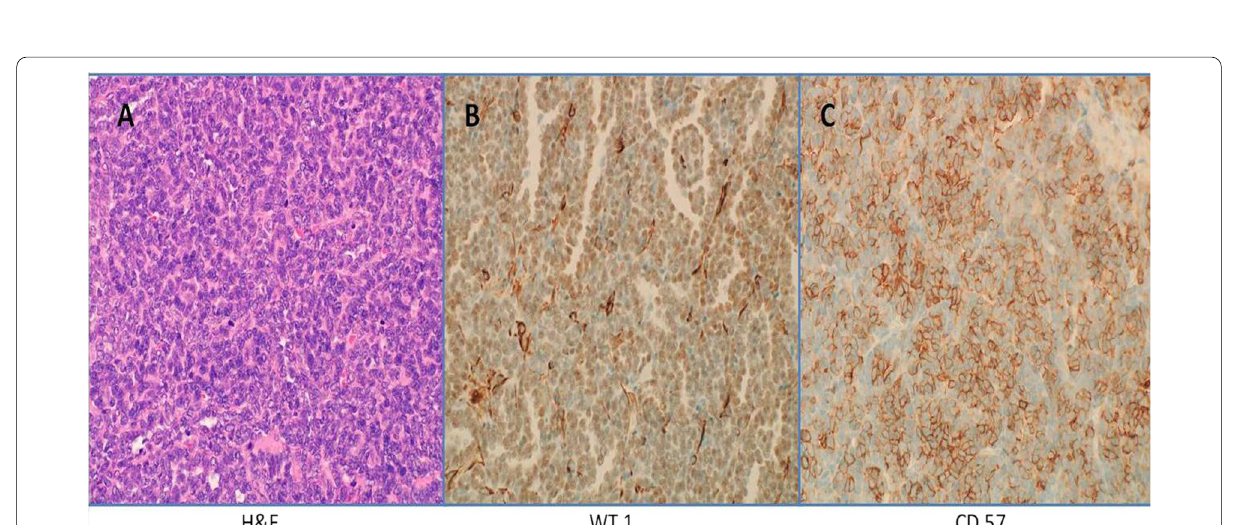
Fig. 3 Histopathological examination. A H&E stain section from the renal mass excised showing a well-circumscribed tumor composed of tightly packed tubules. The cytoplasm is scanty and the nuclei are small and devoid of nucleoli. No mitotic figures or necrosis is present. B , C Immunohistochemical staining of the renal mass with WT1 and CD57 showing positive